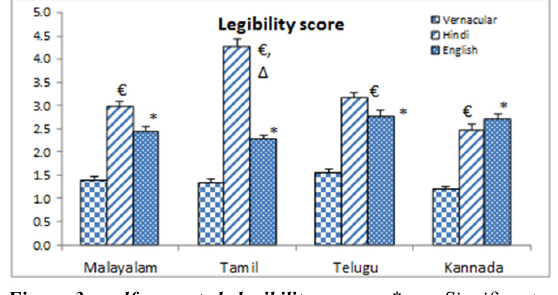
Figure-3: self reported legibility score . * = Significant changes Vernacular vs. English (p˂0.05), € = Significant changes Vernacular vs. Hindi (p˂0.05), ∆ = Significant changes English vs. Hindi